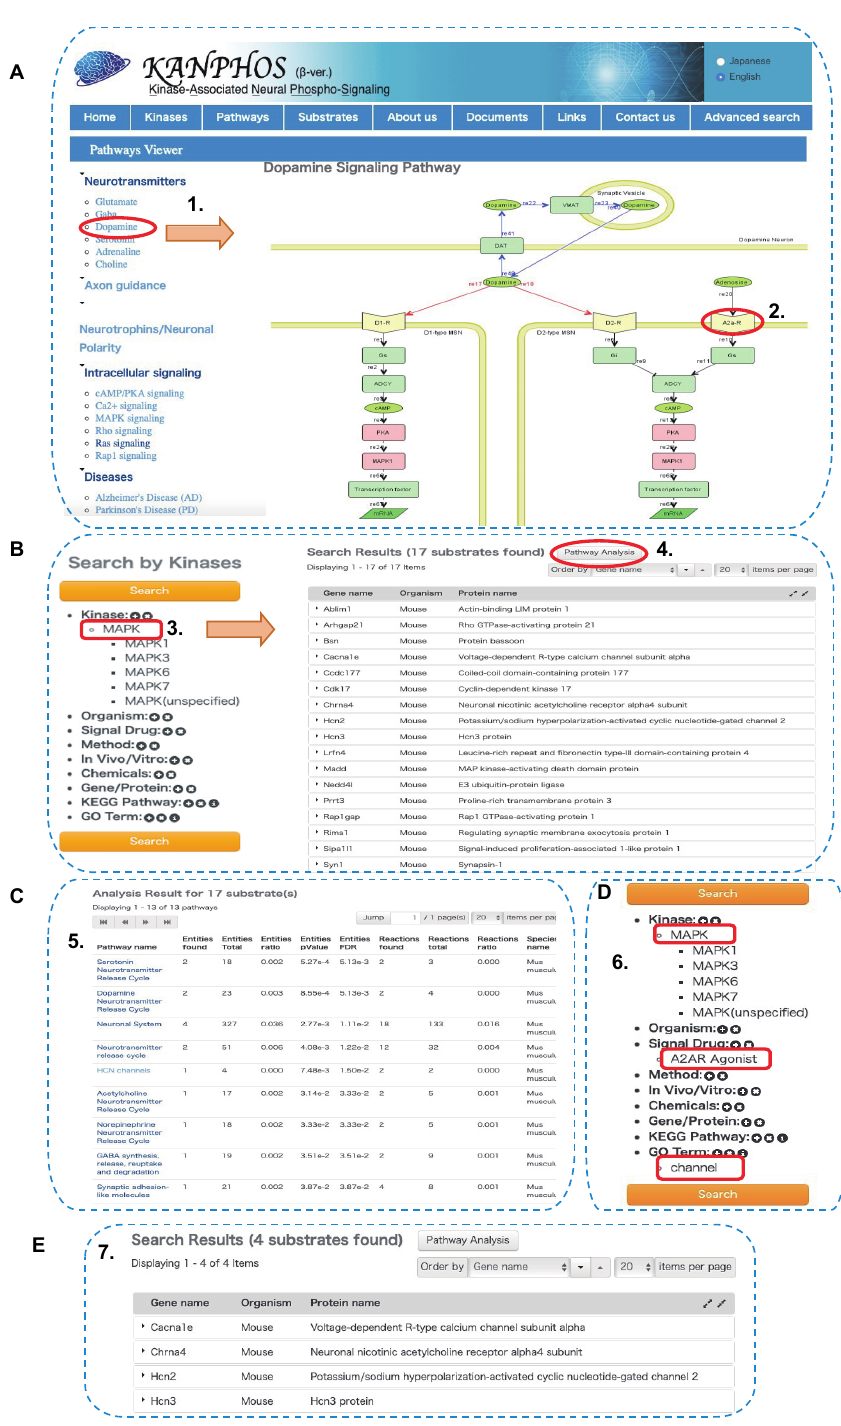
Figure 7. A case study of the KANPHOS revealed that phosphorylation of HCN and calcium channel were involved in the MEK-MAPK pathway downstream of A2AR. ( A ) Pathway viewer window showed dopamine signaling pathway in D1R-MSN and D2R-MSN; ( B ) List of MAPK candidate substrates downstream of A2AR in KANPHOS; ( C ) Results of pathway analysis using KANPHOS; ( D ) Advanced search option for the identification of channel protein in the MEK-MAPK pathway downstream of A2AR; ( E ) List of channel protein involved in the MEK-MAPK pathway downstream of A2AR. Here, number (1–7) indicate the workflow step by step, red circle and red rectangle represent the selected search options, and arrow indicates result output after each